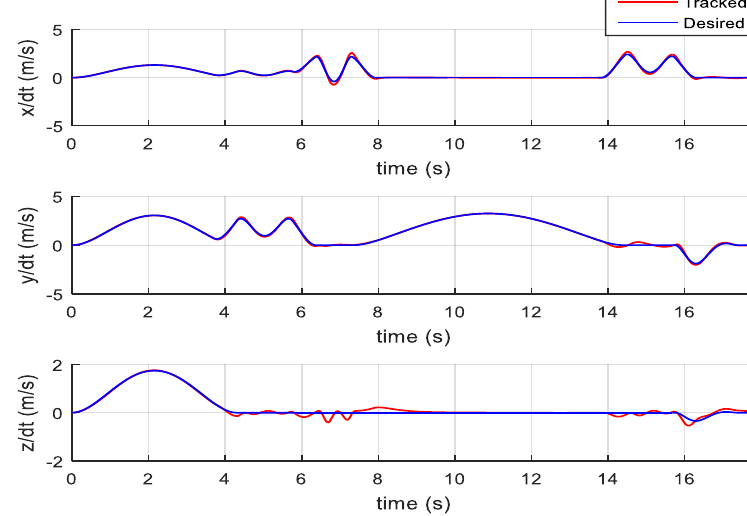
Figure 12. Desired and tracked velocity of each Cartesian state.